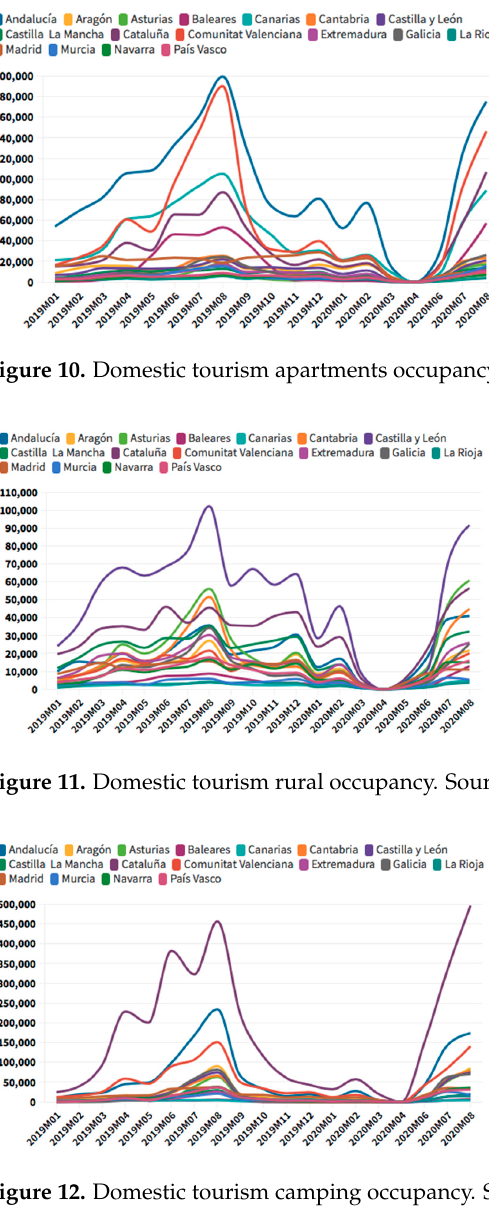
Figure 9. Domestic tourism hotels occupancy. Source: Self-made from INE data.